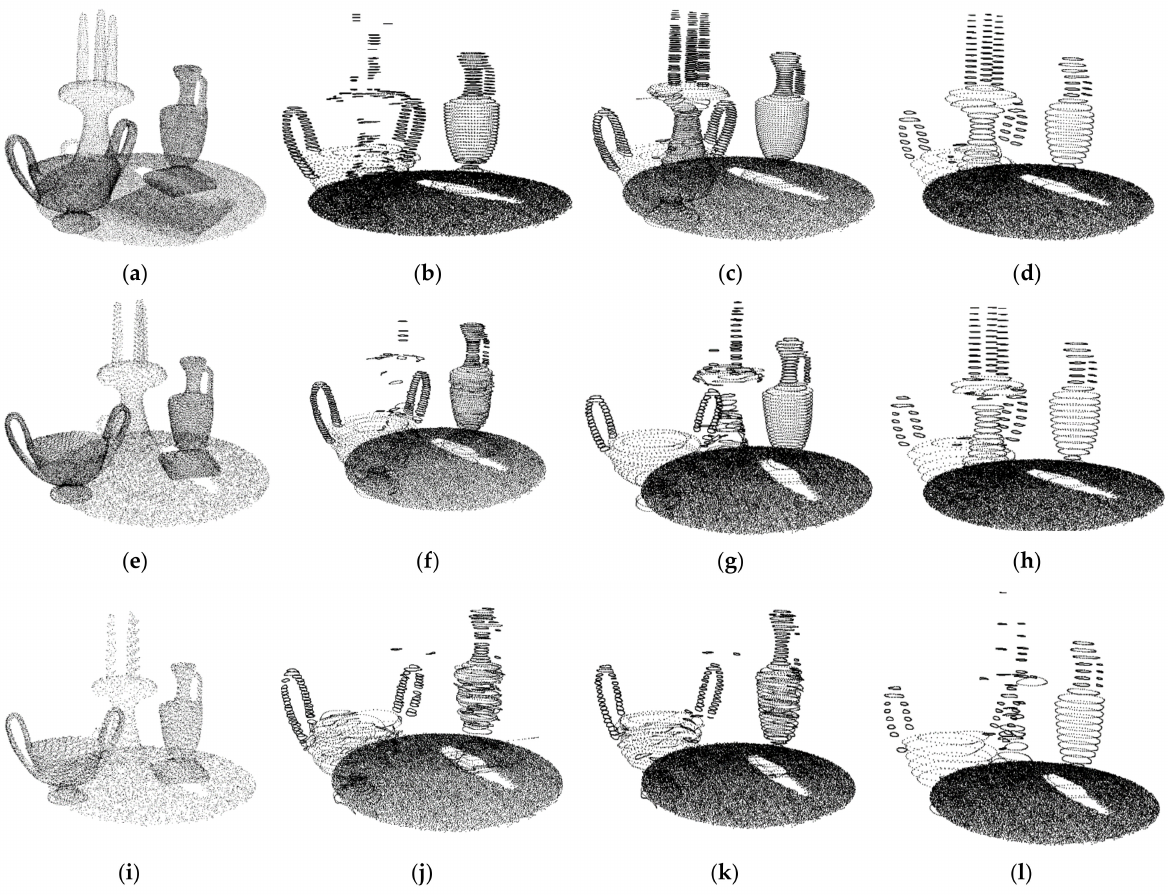
Figure 3. Experimental results of l : ( a ) Scene 1 (99538 points), d dens = 1.431; ( b ) λ d = 0.14, l = λ d d dens ; ( c ) λ d = 0.23, l = λ d d dens ; ( d ) λ d = 0.34, l = λ d d dens ; ( e ) 50% down-sampling model, d dens = 1.995; ( f ) λ d = 0.14, l = λ d d dens ; ( g ) λ d = 0.23, l = λ d d dens ; ( h ) λ d = 0.34, l = λ d d dens ; ( i ) 25% down-sampling model, d dens = 2.779; ( j ) λ d = 0.14, l = λ d d dens ; ( k ) λ d = 0.23, l = λ d d dens ; ( l ) λ d = 0.34, l = λ d d dens